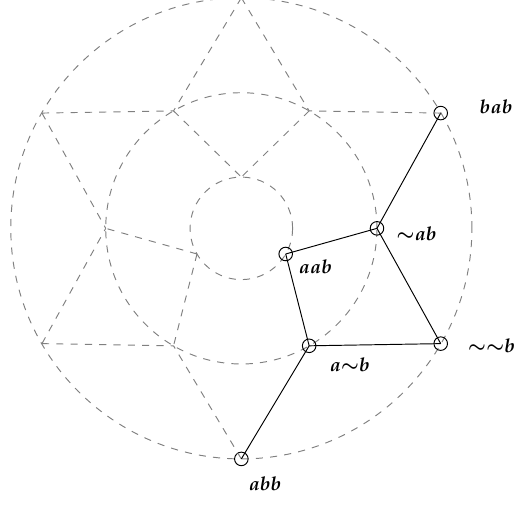
Figure 3. The graph